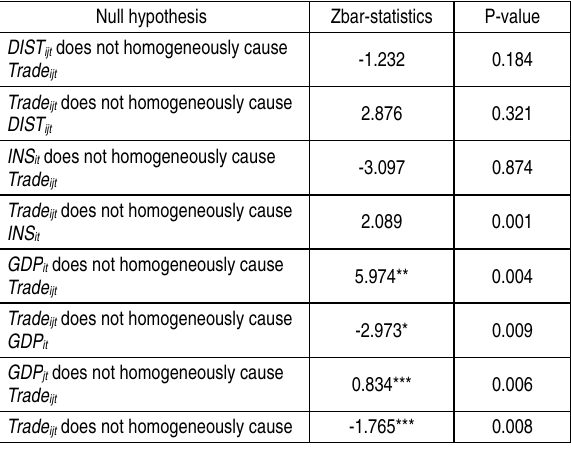
Table 4. Heterogeneous panel causality